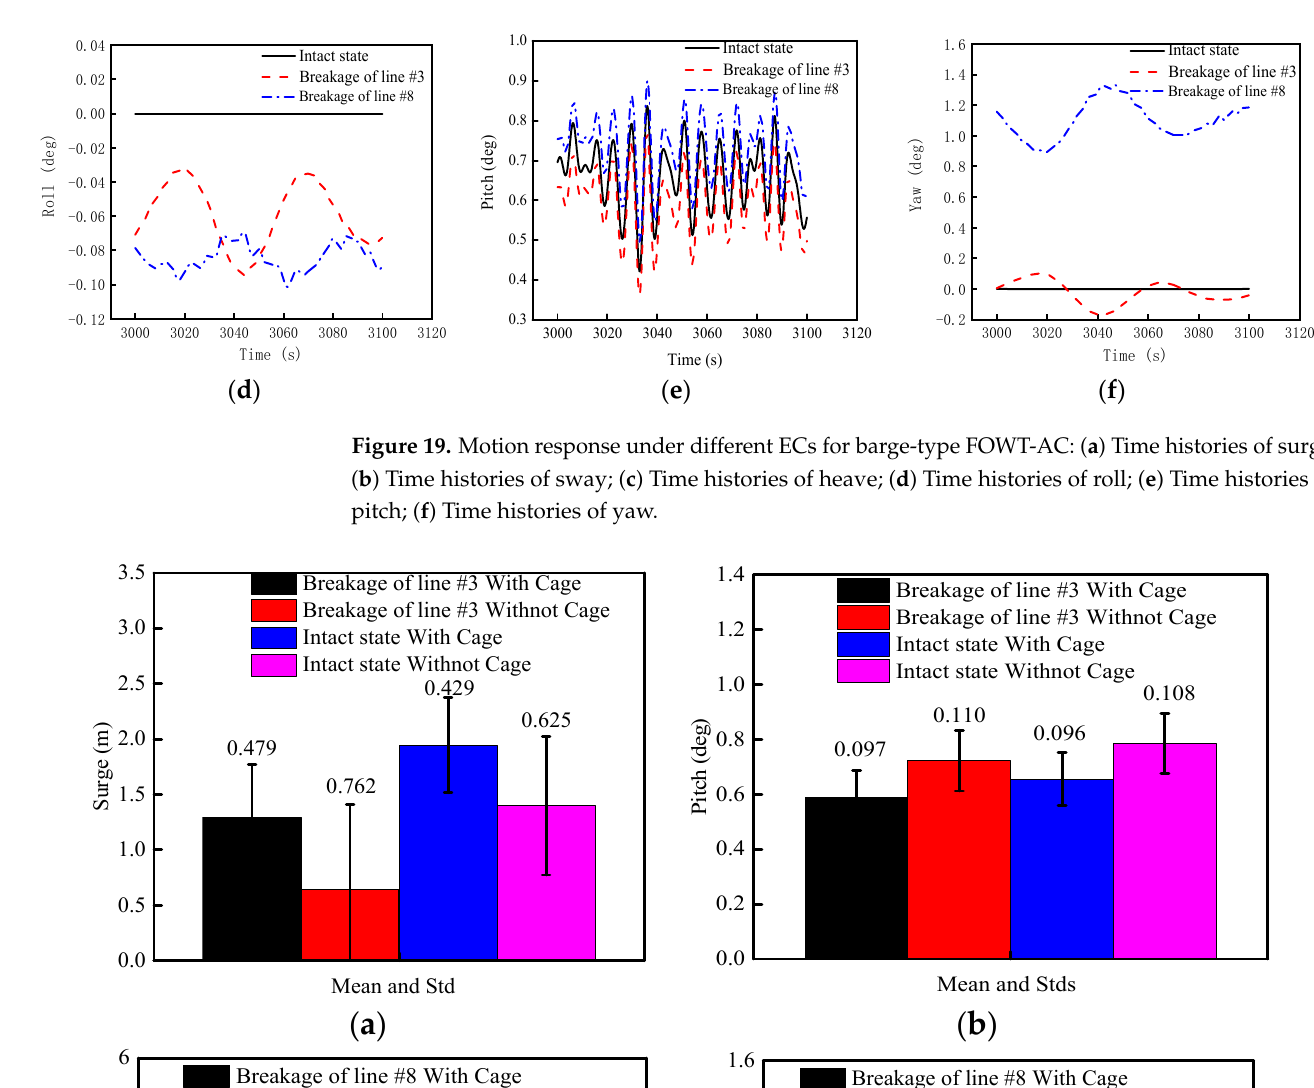
3000 3020 3040 3060 3080 3100